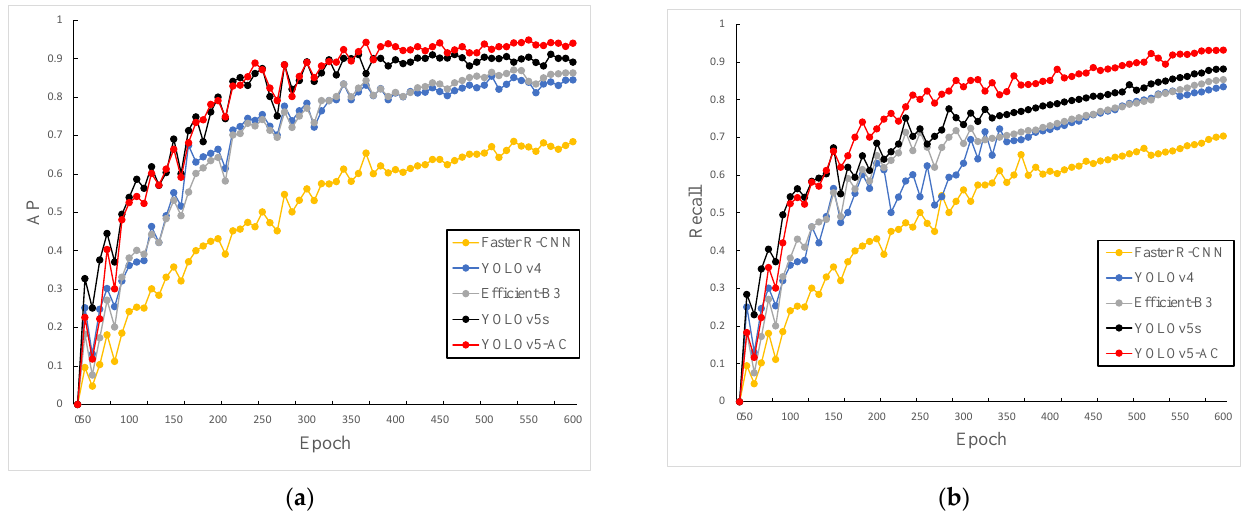
Figure 17. Variation trend of training metrics in the experiment. ( a ) Variation trend of AP. ( b ) Variation trend of Recall.